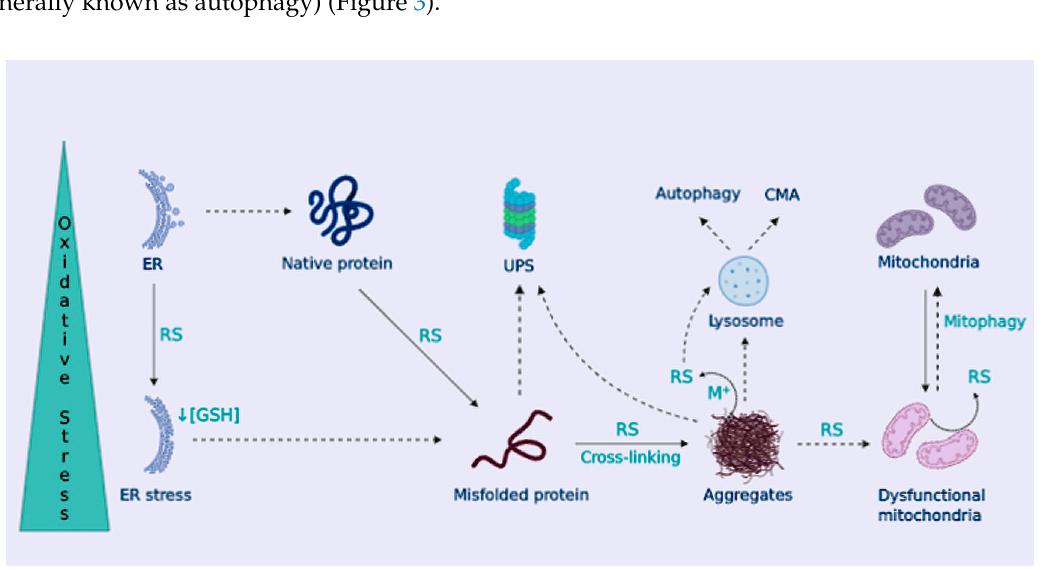
Figure 3. Cellular proteostasis is lost under OS. OS promotes protein misfolding and hydrophobic core exposure, leading to the formation of protein aggregates. Protein control systems, ubiquitin-proteasome system (UPS), chaperone-mediated autophagy (CMA), and macroautophagy (autophagy) are harnessed by OS, favoring protein aggregation. In addition, protein aggregates trap metal ions to produce RS-impairing mitophagy, leading to the accumulation of dysfunctional mitochondria. Also, the ER is damaged by OS, further promoting protein misfolding. In the context of NDDs, the removal of aggregated proteins via autophagy is critical [132]. Autophagy deficits are likely to contribute to neurodegeneration in various diseases [133] and enhance the aggregation of pathological proteins (A β peptide and Tau in AD, α -synuclein in PD, and SOD1 and TAR DNA-binding protein 43 (TDP-43) in ALS). Basal redox-signaling up-regulates autophagy flux [134], indicating a pro-survival response to eliminate oxidized proteins and prevent OS-induced apoptosis, while excessive activation of autophagy promotes cellular death. Redox-sensitive autophagy proteins like p62 possess oxidizable Cys residues that increase autophagy flux upon oxidation [135]. Similarly, OS conditions intensify the removal of oxidized proteins through CMA by upregulating LAMP-2A levels [136]. OS can also destabilize lysosomes, impairing autophagy [137], which leads to the accumulation of cross-linked aggregates in the form of lipofuscin [138] (Figure 3). Nonetheless, the effect of chronic OS and impaired autophagy in NDDs still needs further investigation [139]. 4. Neuroinflammation in Neurodegeneration The immune response within the brain is a tightly regulated process constituted by different molecular and cellular mechanisms including immune cells, blood vessels, and molecular mediators [140]. Microglia and astrocytes, and also, peripherally derived T cells, macrophages, and dendritic cells inspect the healthy CNS for harmful agents [141]. To provide innate immunity, microglial cells express Toll-Like Receptor (TLRs), NOD-like receptors (NLRs), and scavenger receptors [142]. When microglial cells are triggered (“classical activation”), they release high levels of pro-inflammatory cytokines such as tumor necrosis factor α (TNF α ), interleukin 1 beta (IL-1 β ) and IL-6, and chemokines (such as monocyte chemoattractant protein-1, MCP-1), and they increase the expression of the inducible nitric oxide synthase (iNOS) and NOX enzymes [143] (Figure 4). Following classical activation, microglia switches to an “alternative activation” that participates in inflammation resolution and tissue repair. These microglial cells are characterized by branched processes, and they release anti-inflammatory cytokines (IL-10 or IL-4), neurotrophic factors, and up-regulate molecular markers such as Arginase-1 and transforming growth factor beta (TGF β ) [144].